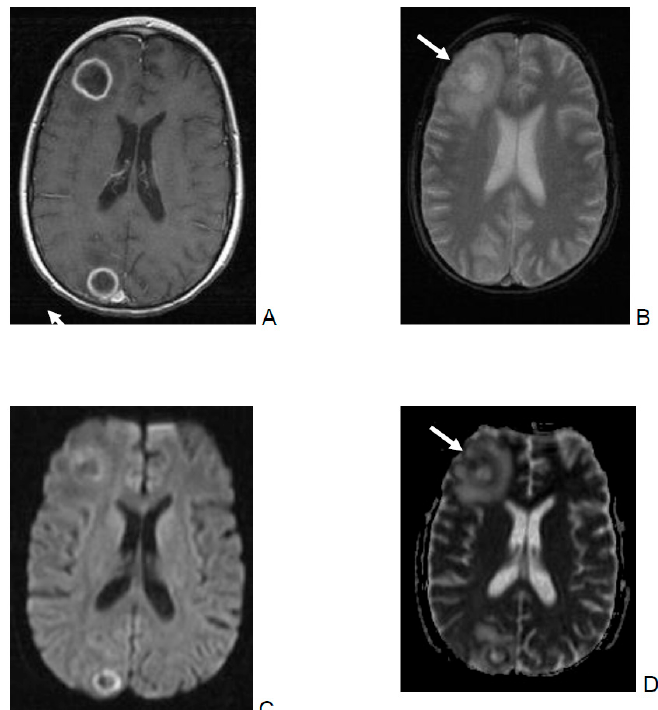
Figure 2. Multiple abscesses in the right hemisphere of a 15-year-old boy with non-Hodgkin lymphoma. Culture grew Aspergillus fumigatus . The patient is alive with no neurological sequelae. Two lesions are seen with a slightly hypointense wall on axial T2* image ( B ), which show well-defined ring enhancement on the post-contrast T1-W image ( A ). Diffusion, b = 1000 s/mm 2 ( C ) shows ring-like hyperintensity with low ADC (0.54 × 10 − 3 mm 2 /s) ( D ). Note that fungal abscesses may have a variable imaging appearance but are often multiple and near the grey–white matter junction. The pattern of diffusion restriction of the wall without central restriction correlates more with a fungal abscess than a pyogenic abscess. On DWI/ADC ( C and D ) the walls as well as the small nodular soft tissue (straight arrows) display diffusion restriction, while the contents do not show restriction. There is perilesional